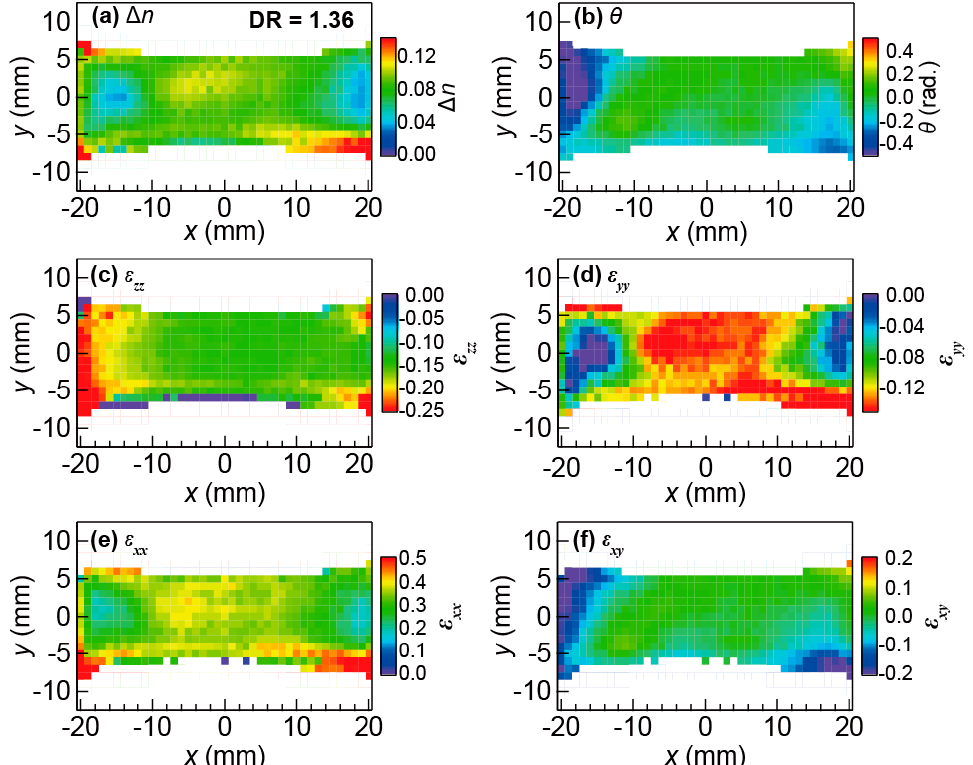
Figure 6. The spatial mapping of (a) the degree of the birefringence and (b) the angle of the slow optic axis of the SBR sample with a CB amount of 15 wt % for DR = 1.36; (c)–(f) The internal triaxial strain images of (cid:101) xx , (cid:101) yy , (cid:101) xy and (cid:101) zz , respectively, derived from (a) and (b). Reproduced from A. Moriwaki et al . APL Photon. 2 , 106101 (2017) [42]. Licensed under CC BY 4.0.